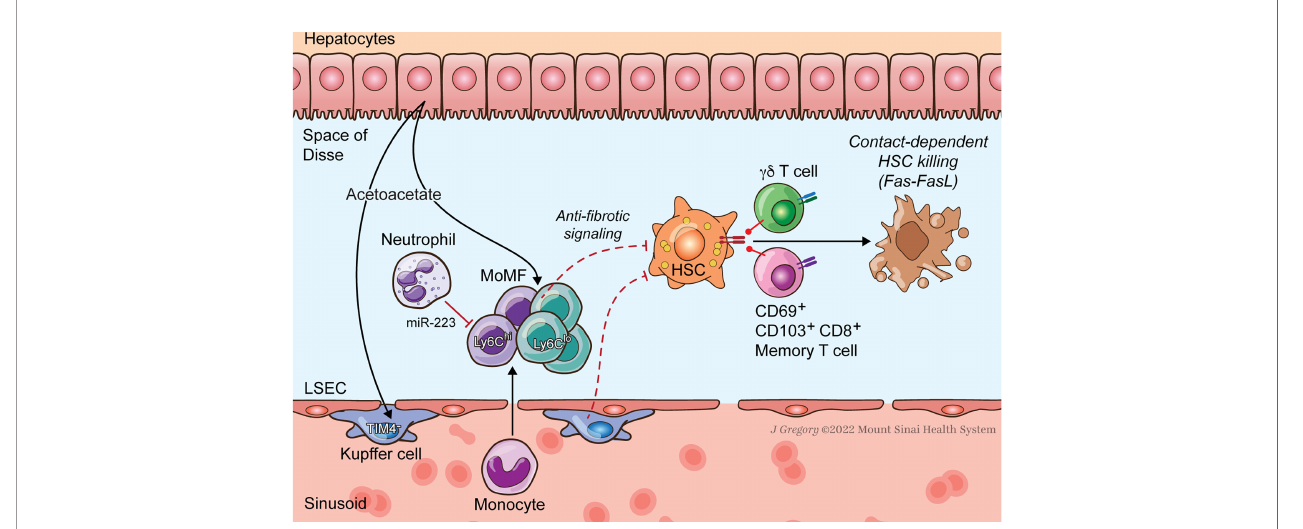
FIGURE 2 | HSC-Immune Interactions in NASH Regression. Key immune pathways oppose fi brogenesis during resolution of NASH injury. CD8 + memory and gd T cells induce apoptosis of activated HSCs. Neutrophil microRNA 223 (miR-223) converts pro-in fl ammatory macrophages to a restorative phenotype. Hepatocyte- released acetoacetate promotes anti- fi brogenic signaling by